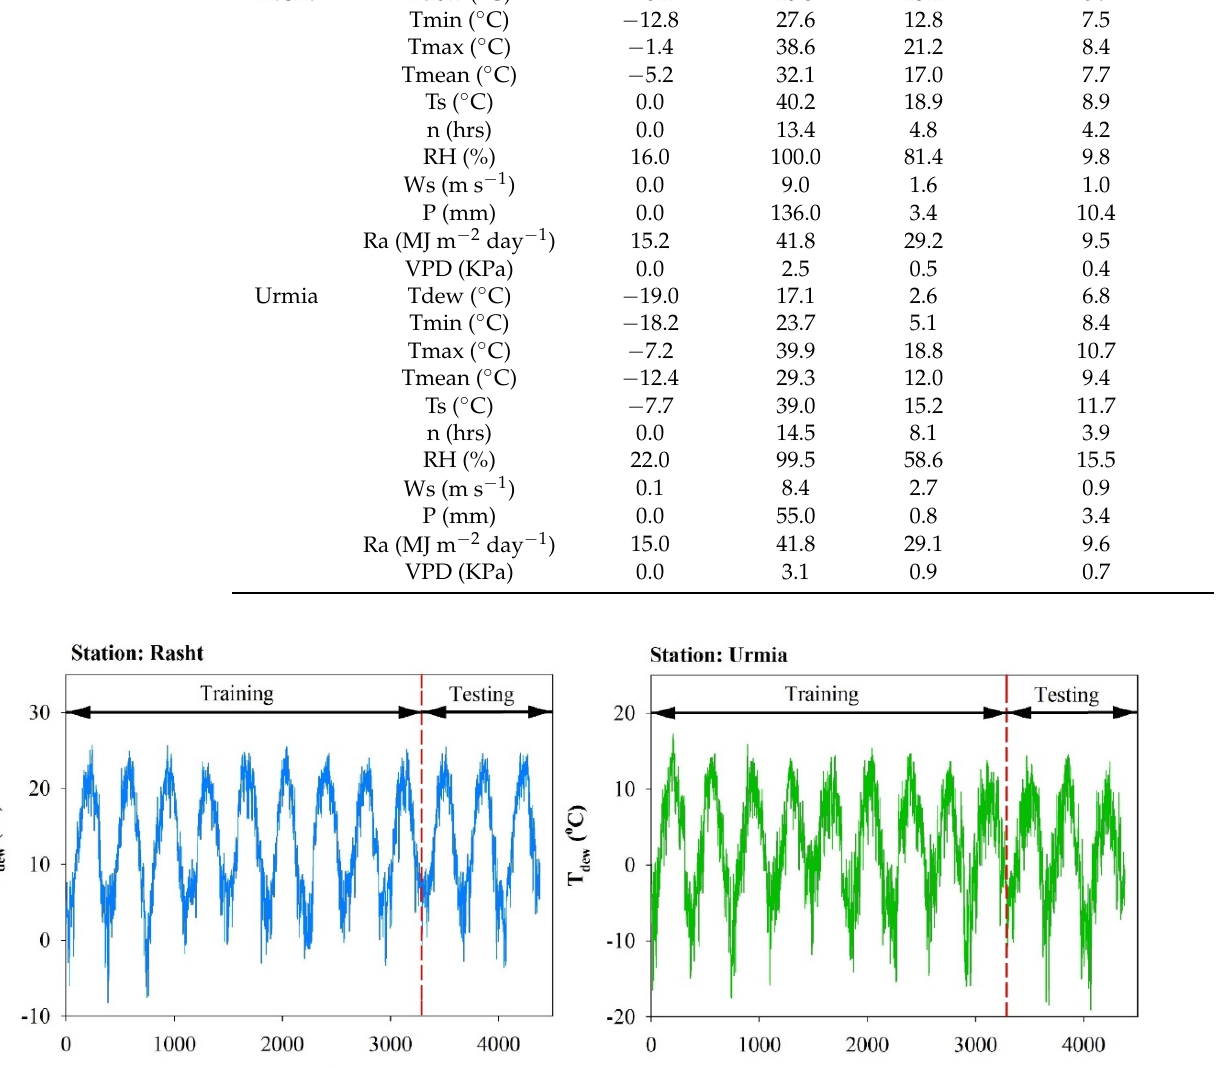
Table 1. Daily statistical parameters of the weather variables for the studied stations during 2006–2017.